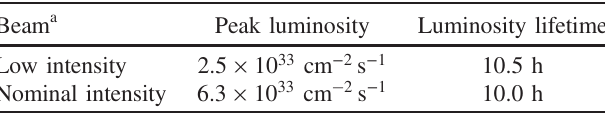
TABLE III. Failure rates and repair times for